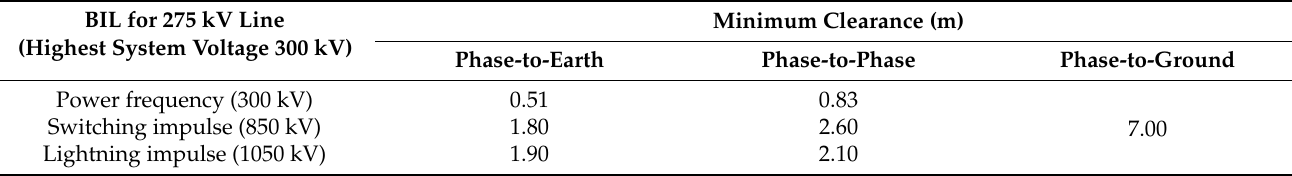
Figure 3. Techniques and processes of the voltage uprating proposed method. Table 1. Requirement of electrical clearance under still air condition